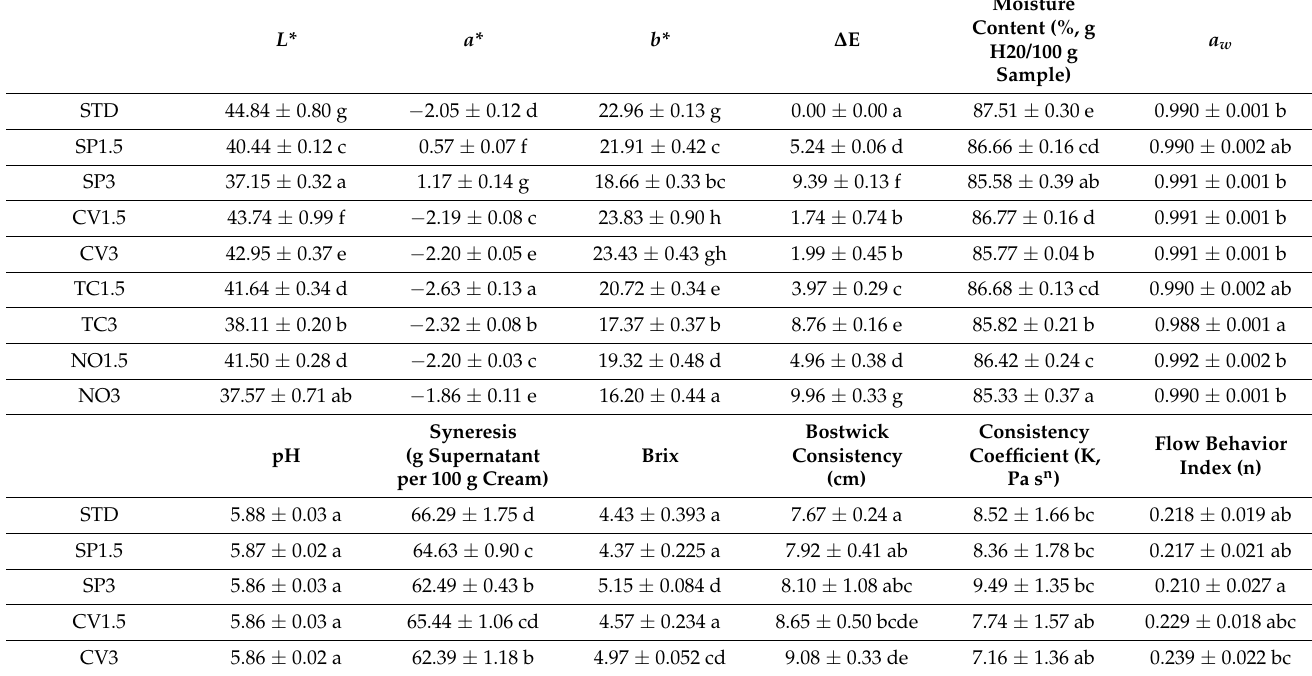
Table 3. Physicochemical properties of vegetable creams reformulated with different microalgae and two levels of